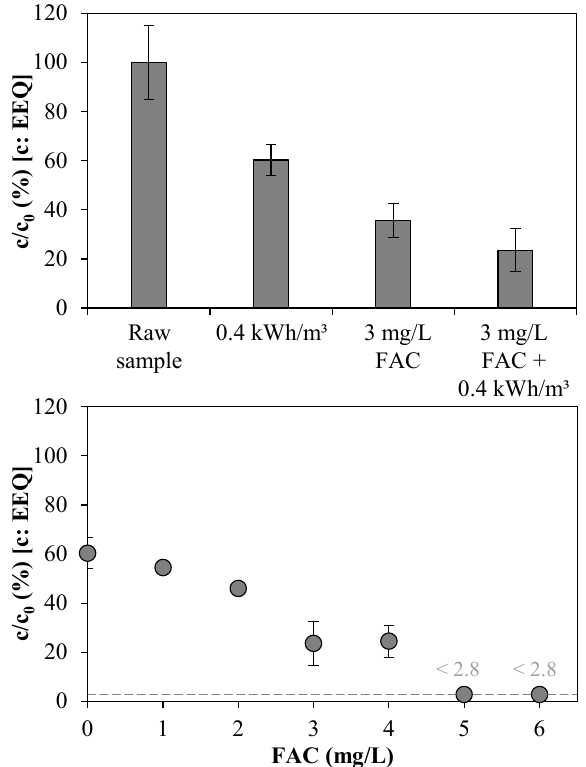
Figure 7. Effect of UV/chlorine AOP on total estrogenic activity of WWTE: measured in 17 β -estradiol equivalents (EEQ) at different process settings at 1 m 3 /h ( Top ) (Experiment 1); and as a function of FAC concentration in UV chamber influent at 0.4 kWh/m 3 energy consumption (1 m 3 /h, 0.4 kW) ( Bottom ) (Experiment 2). Dashed line: LOQ of 0.1 ng/L EEQ (here 2.8%).